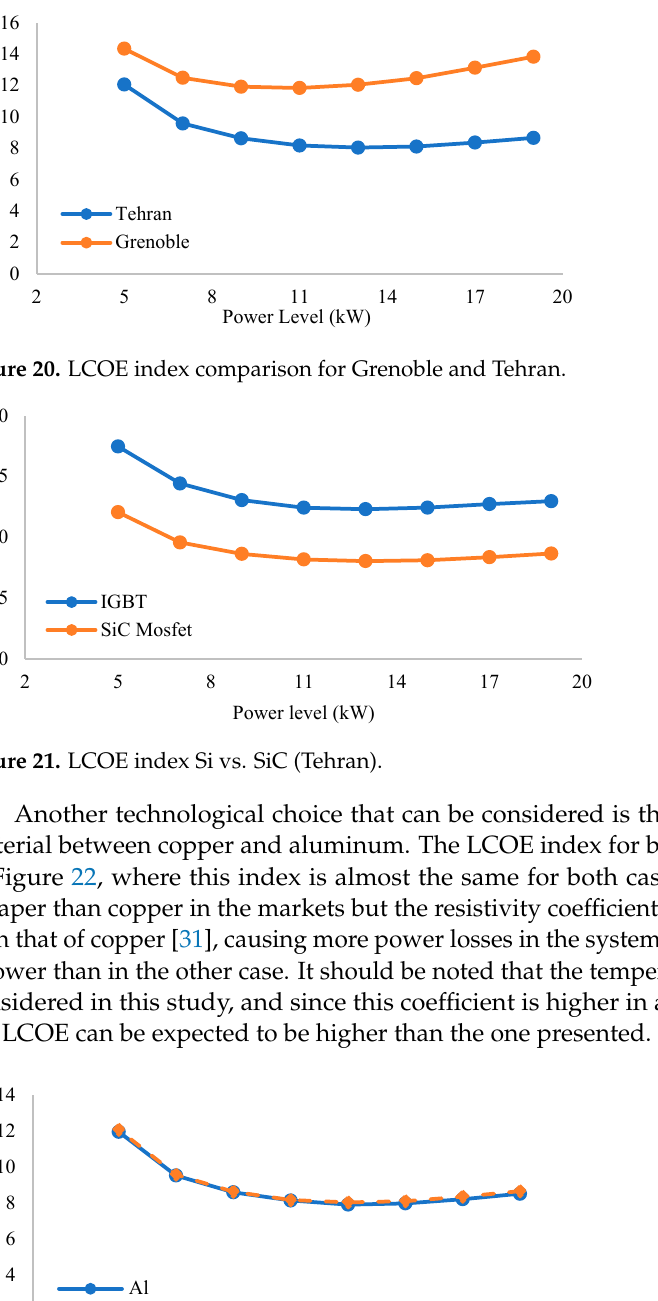
Figure 20. LCOE index comparison for Grenoble and Tehran.